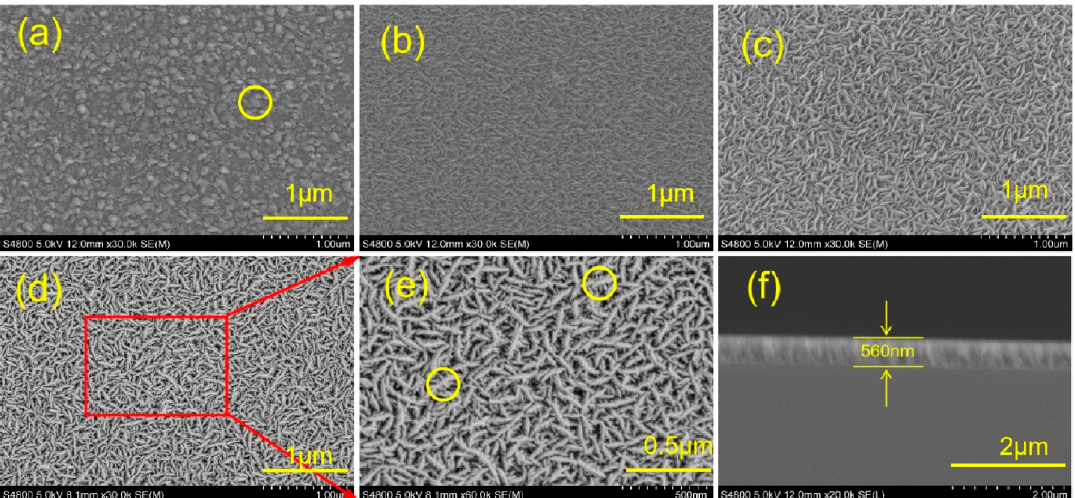
Figure 1. Scanning electron microscope (SEM) images of the MoS 2 films prepared at different deposition temperatures: ( a ) 50 °C, ( b ) 100 °C, ( c ) 200 °C, ( d ) 300 °C, ( e ) high magnification, ( f ) cross section.